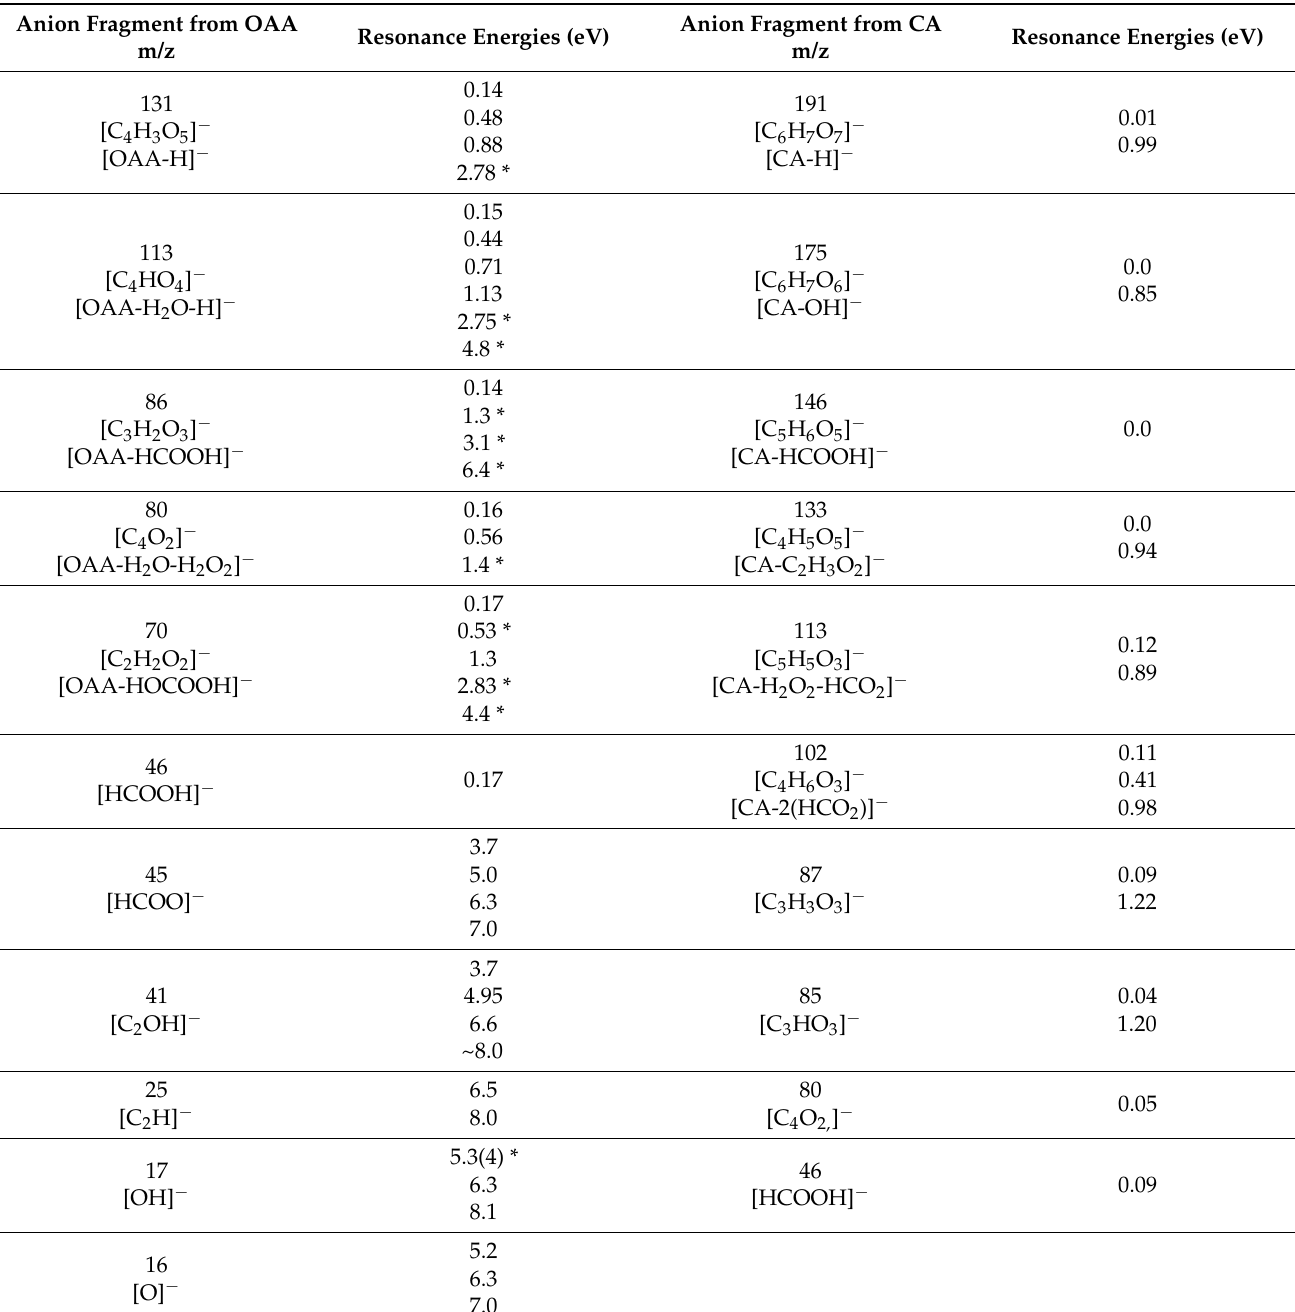
Table 1. List of the detected m/z negative species created by DEA to oxaloacetic acid (OAA) (left) and to citric acid (CA) (right). The resonance energies are obtained from Figures 2 and 3. The suggested associated radical to the negative fragments and its formation energy are discussed in the text. (* weak peak). In blue the same formula is given in terms of neutral loss